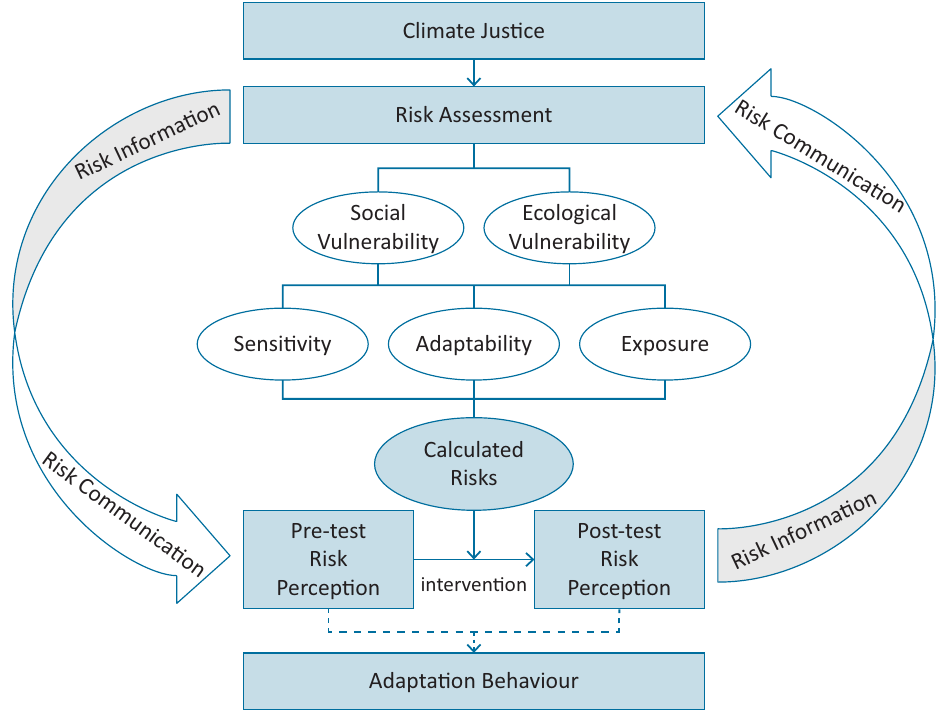
Figure 1. Research framework of relationships between climate justice and dimensions of risk assessment, risk communi- cation, risk perceptions and adaptation behavior. Risk communication using scientifically determined risks (i.e., calculated risks) serves as an intervention in this study to gauge residents’ subjective assessment of risk perceptions that affect adap- tation behaviors (dashed line indicates using perceived preparedness as a proxy for adaptation